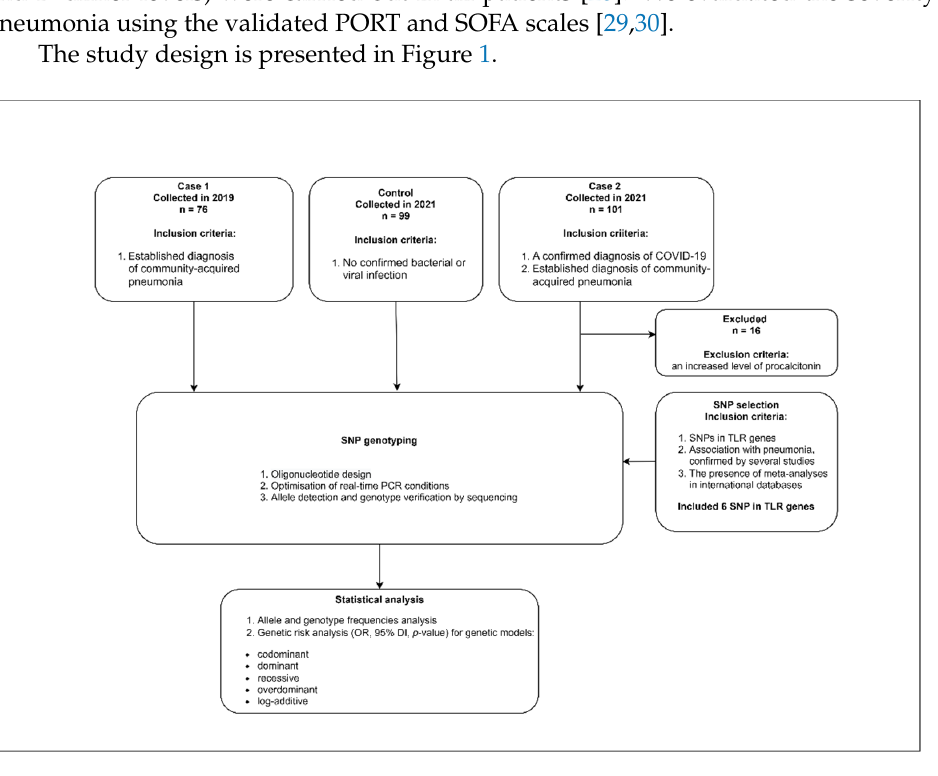
Table 1. Selected SNPs in TLR genes associated with pathological conditions.